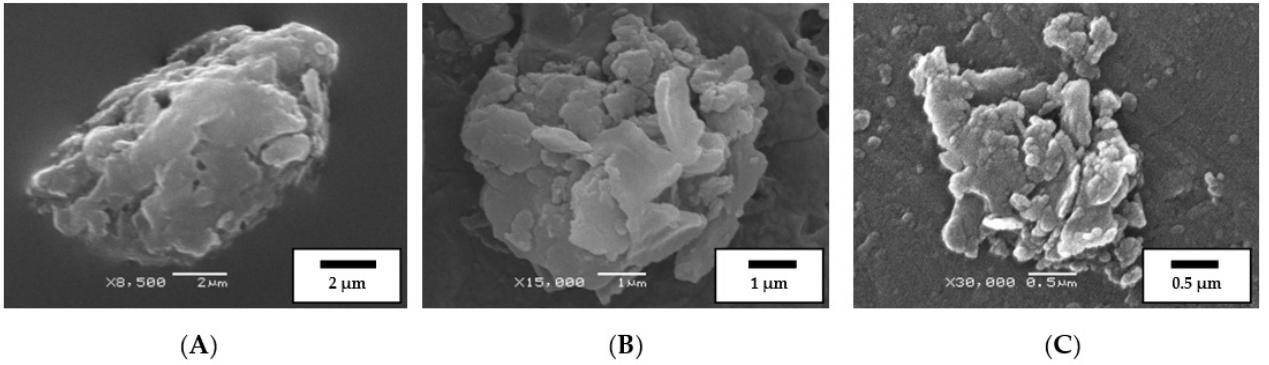
Figure 4. SEM images of characteristic fragments of rubber particles on the filter after washing bitumen from the modified binder with solvent. MB preparation time 1 min at 120 °C ( A ); 140 °C ( B ); 180 °C ( C ).